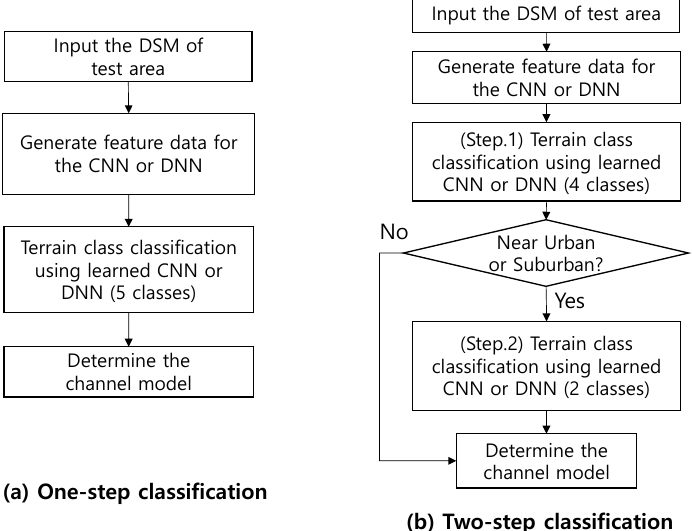
Figure 6. The decision process of the proposed NN-based topography class classification.